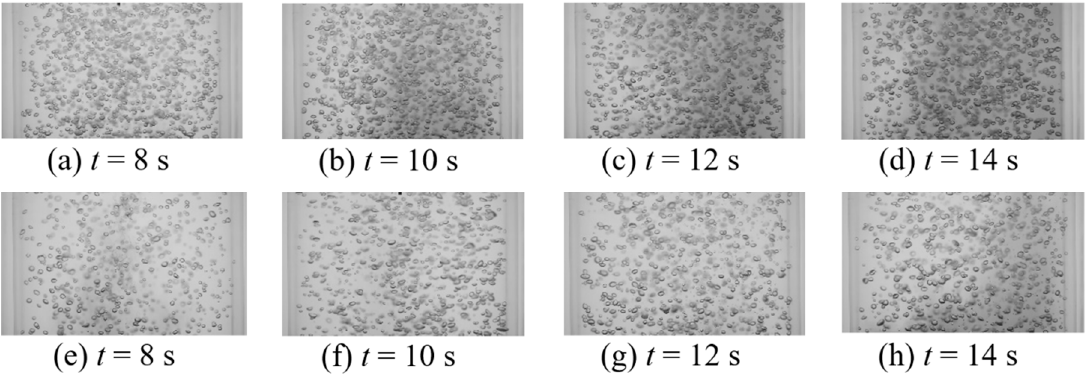
Figure 10. Instantaneous images of mixing of the dye in ( a – d ) static (experiment #1 from Table 1) and ( e – h ) vibrating (vibrating experiment #1 from Table 2) bubble column.